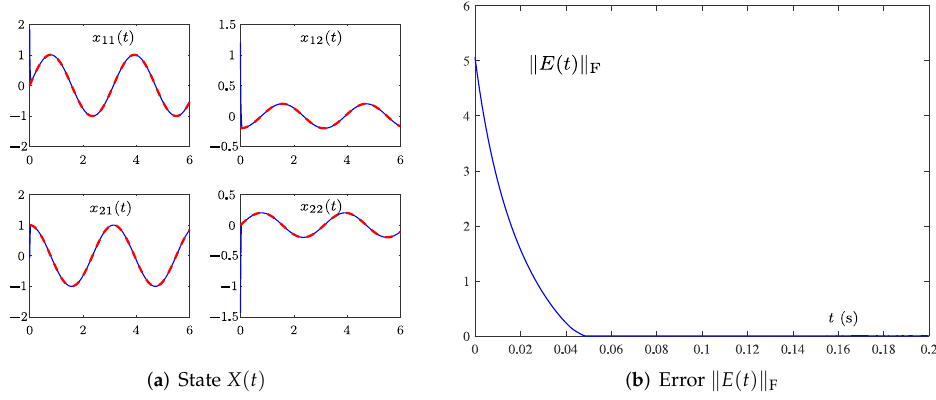
Figure 3. Simulation results by the PTCAZNN model (15) with λ = 10 for TVMIP of (40) under the same single-harmonic noise when f = 0.01